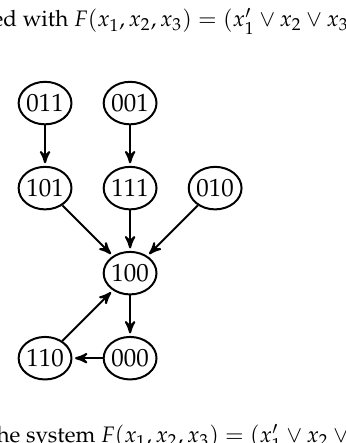
Figure 12. Phase portrait of the system F ( x 1 , x 2 , x 3 ) = ( x (cid:48)